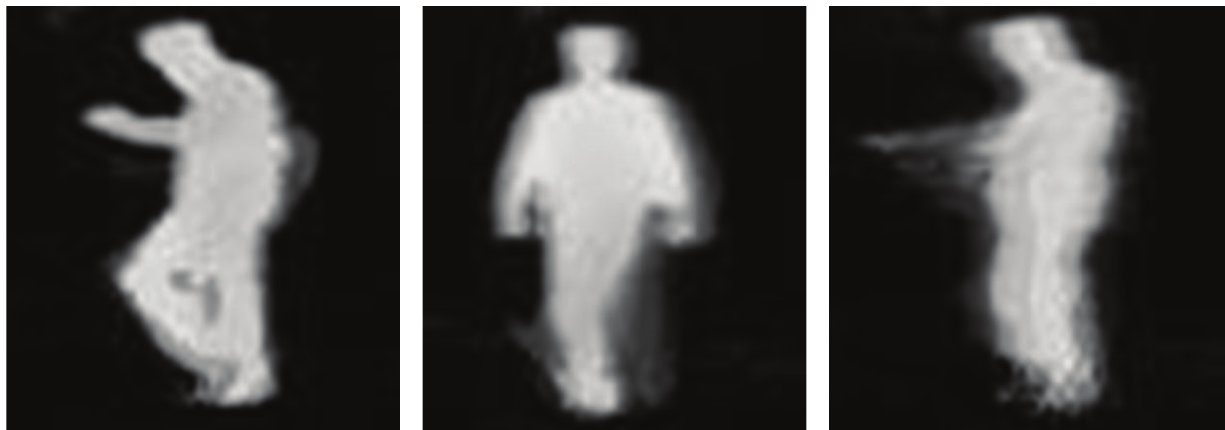
Figure 4: Depth sequential history features applied over exercise, kicking, and cleaning